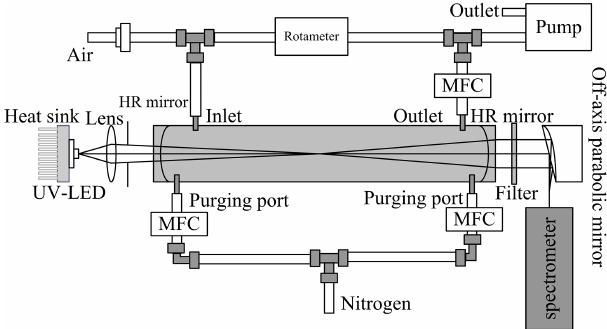
Figure 1. The optical layout of the IBBCEAS system. MFC repre- sents the mass flow controller, and HR mirror represents the high- reflectivity